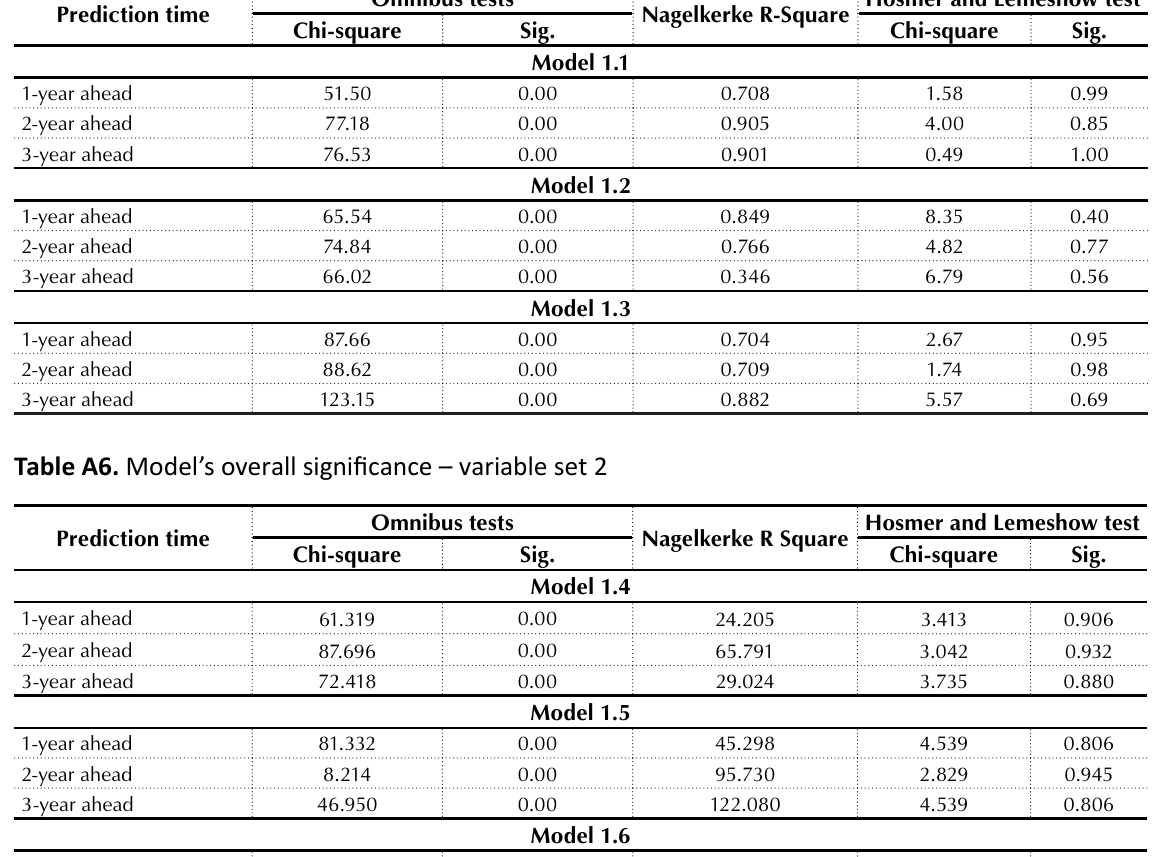
Table A5. Model’s overall significance – variable set 1 Prediction time